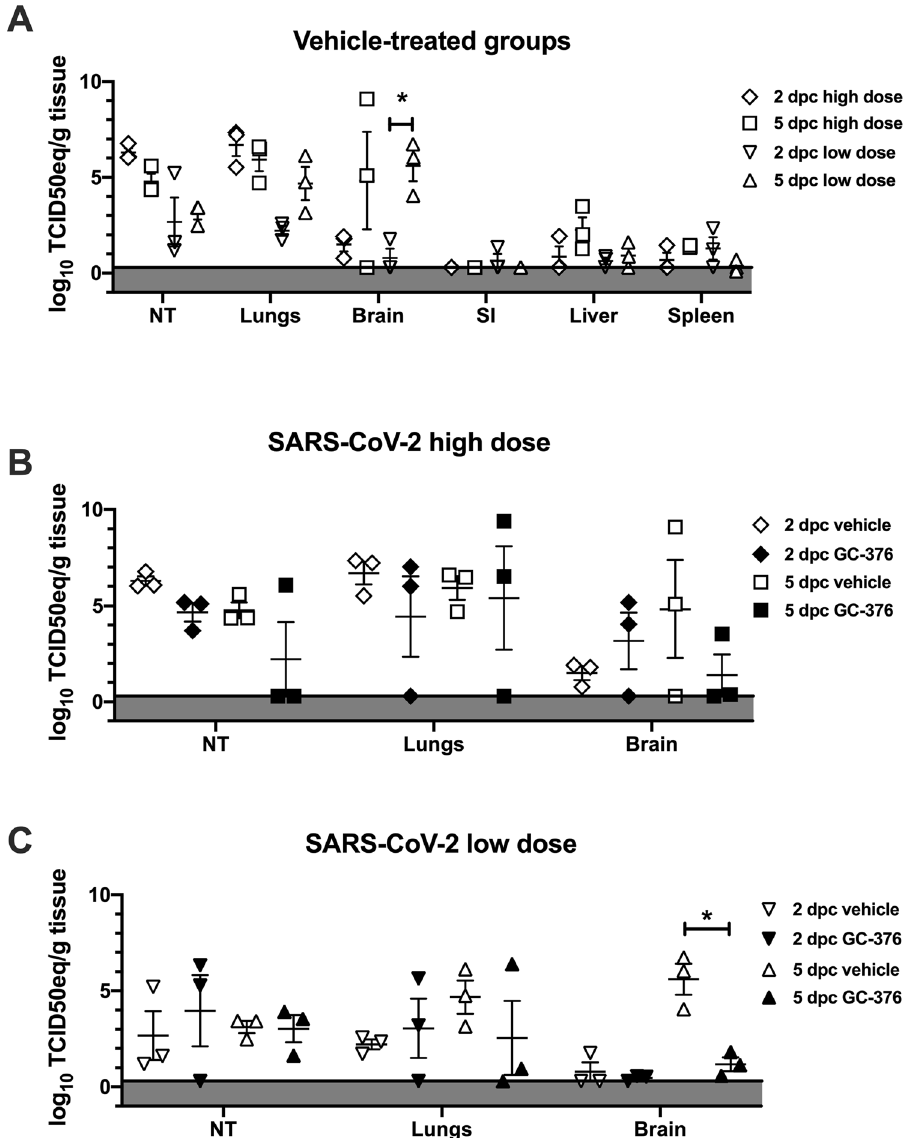
Figure 3. Viral loads in different mouse tissues at 2 and 5 dpc after SARS-CoV-2 challenge. Subsets of mice (n = 3/group/time point) were humanely euthanized at 2 and 5 dpc. Lungs, brain, SI, liver, spleen and NT were collected. ( A ) Viral loads from G3 (high dose/vehicle) and G5 (low dose/vehicle) were determined by RT-qPCR and expressed as log 10 TCID50 equivalent (TCID50eq) per gram of tissue. Mice challenged with high dose of SARS-CoV-2 euthanized at 2 dpc (clear diamond) and 5 dpc (clear squares) or challenged with low dose of SARS-CoV-2 euthanized at 2 dpc (clear inverse triangle) and 5 dpc (clear triangles). Viral loads in lungs, brain and NT from mice challenged with ( B ) high dose or ( C ) low dose of SARS-CoV-2 and treated with drug-vehicle (clear) or GC-376 (black) were analyzed from samples collected at 2 and 5 dpc. The mean ± SEM is shown. Statistical analysis was performed by a two-way ANOVA with a Dunnett’s multiple comparisons test, *p <